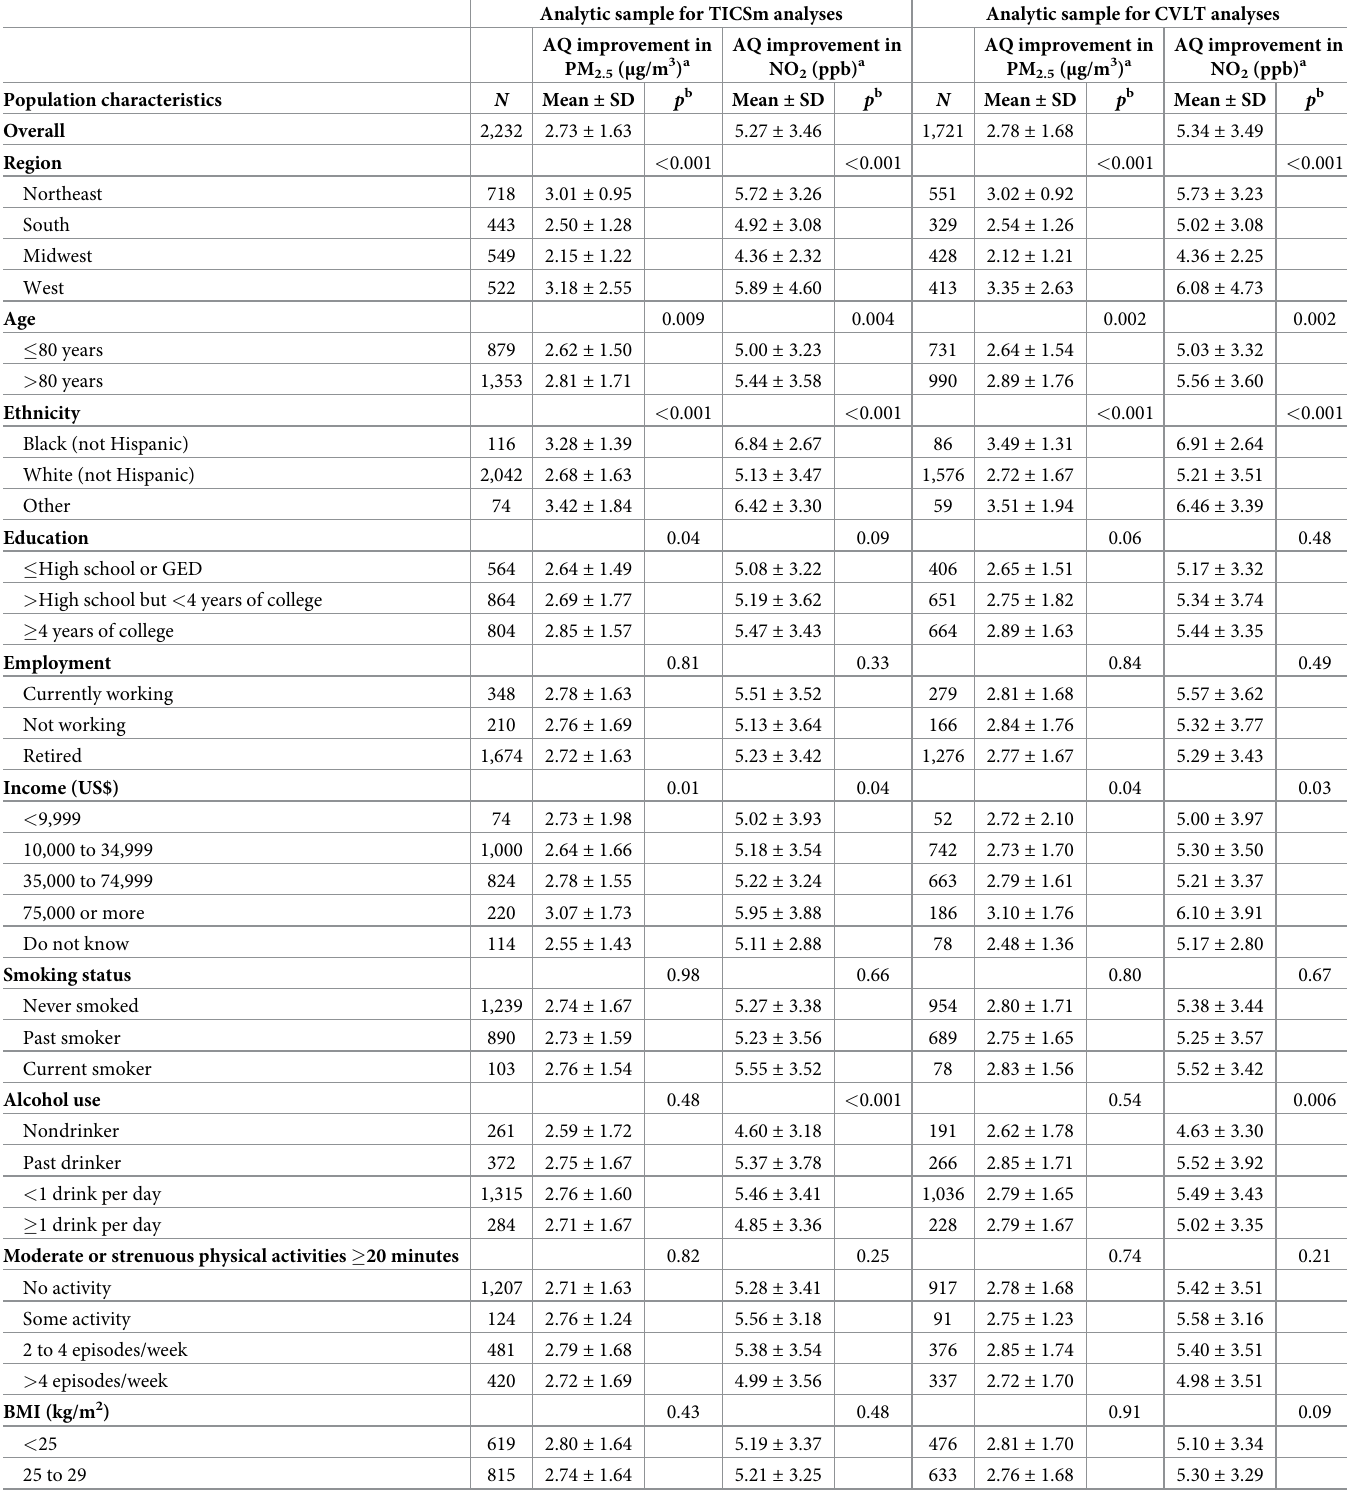
Table 2. Distribution of AQ measures by population characteristics in the WHIMS-ECHO cohort, 1998 to